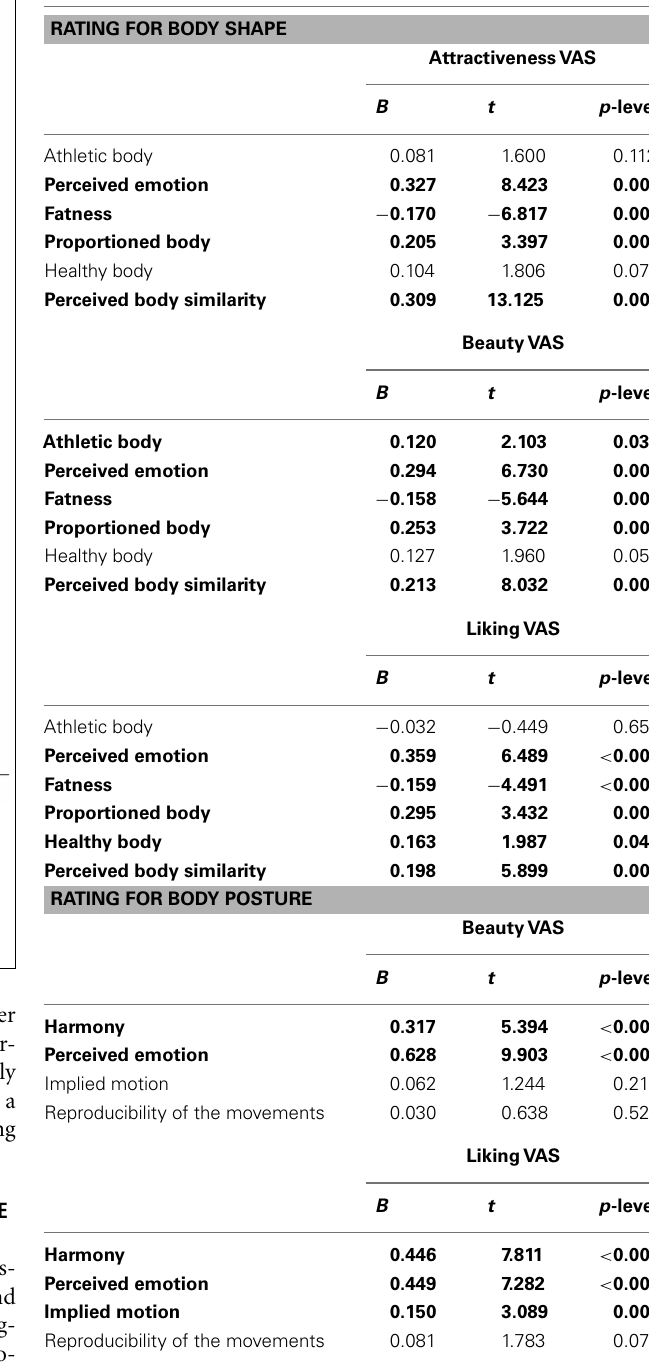
Table 2 | Results of multiple regression analysis on affective and perceptual dimensions predicting attractiveness, beauty, and liking judgments for human models in body shape and body posture